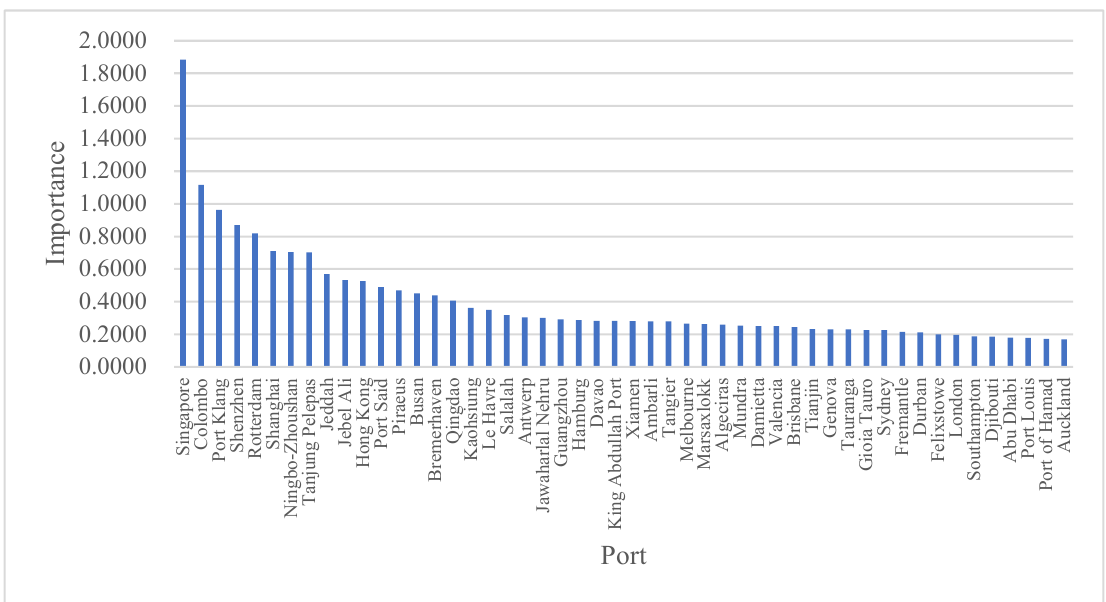
Figure 4. The importance of the top 50 ports.